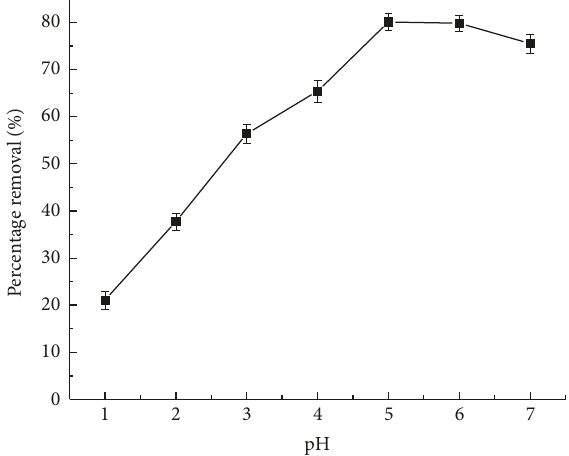
Figure 4: Effect of pH for Cr(VI) adsorption using hybrid mem- brane of carboxymethyl chitosan and silicon dioxide.